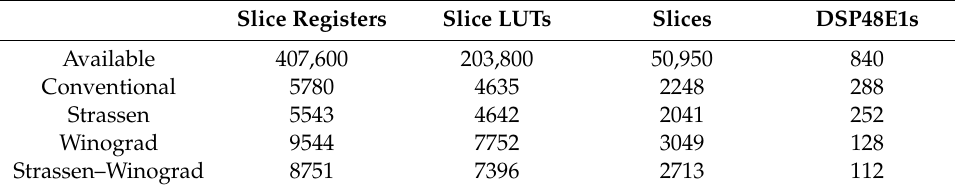
Table 2. Device utilization summary.